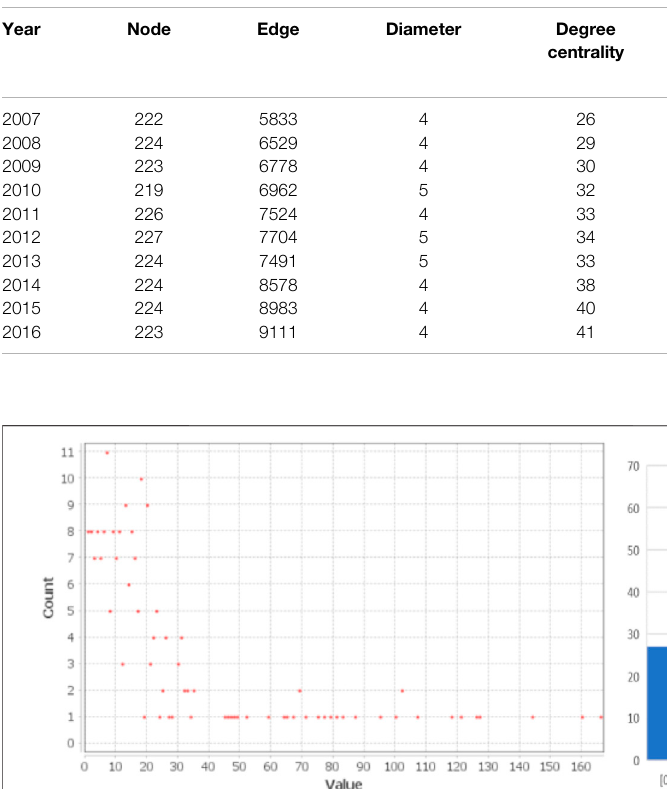
TABLE 1 | Statistics on complexity characteristics of international student mobility from 2007 to 2016.